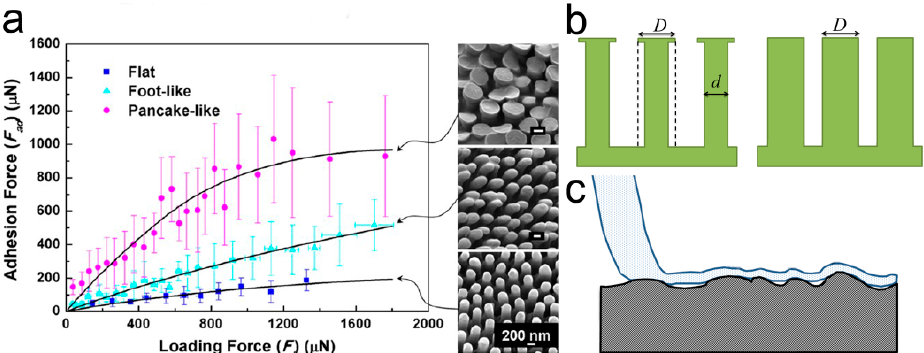
Figure 6. Adhesion performances of pillars with various tip geometries. ( a ) Influence of the tip geometry of polystyrene (PS) nanorods on adhesion forces. A scanning electron microscopy (SEM) image of the corresponding tip is shown in the right column. Reproduced with permission from [24].